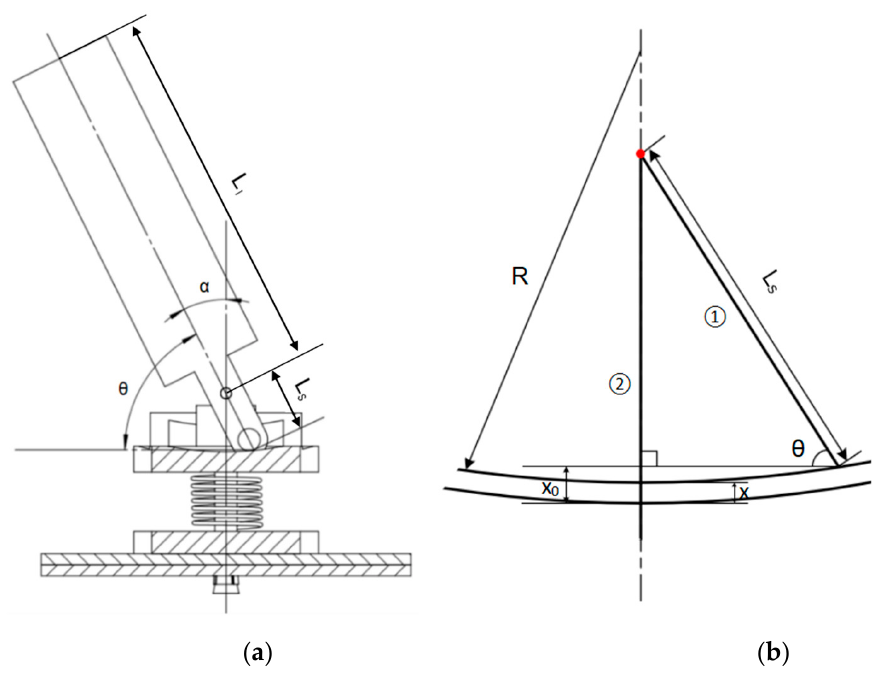
Figure 3. ( a ) Geometric relationship of temporary fasteners. ( b ) Geometric relationship analysis. At the clamping stage, the bottom of the lever moves from position ① to position ② , making circular motion with the fulcrum as the sports center. The angle between the horizontal line and the center line of the lever at the beginning of the clamping stage is θ , and α is the angle between the center line of the lever and the vertical line.